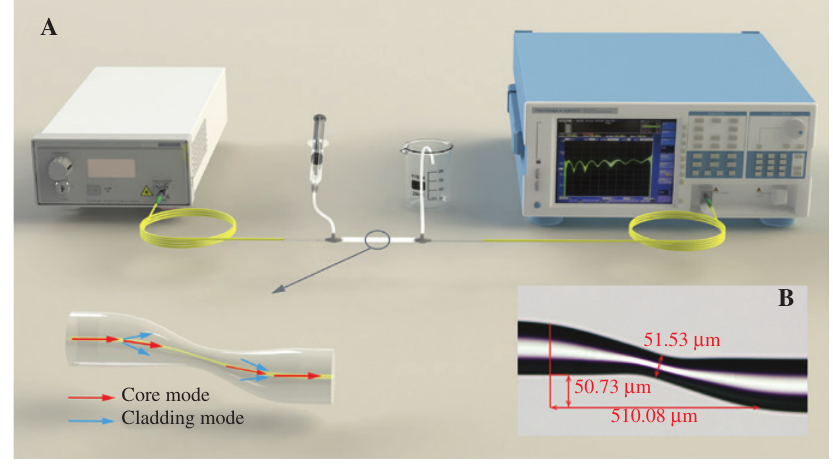
Figure 2: Experimental setup. (A) Schematic diagram of experiment setup for GAR–R interaction detection system. (B) Microscopic image of fabricated S-taper